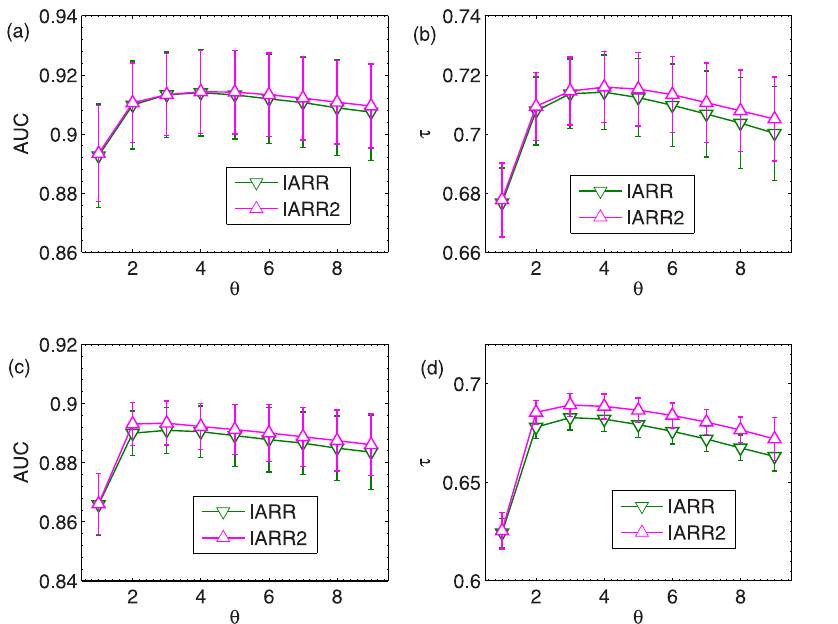
Figure 3. (a) and (b) the dependence of AUC and t on h in IARR and IARR2 methods in the random rating attack case. (c) and (d) the dependence of AUC and t on h in IARR and IARR2 methods in the malicious rating attack case. The results in this figure are averaged over 10 independent realizations. The error bars are the corresponding standard deviations.